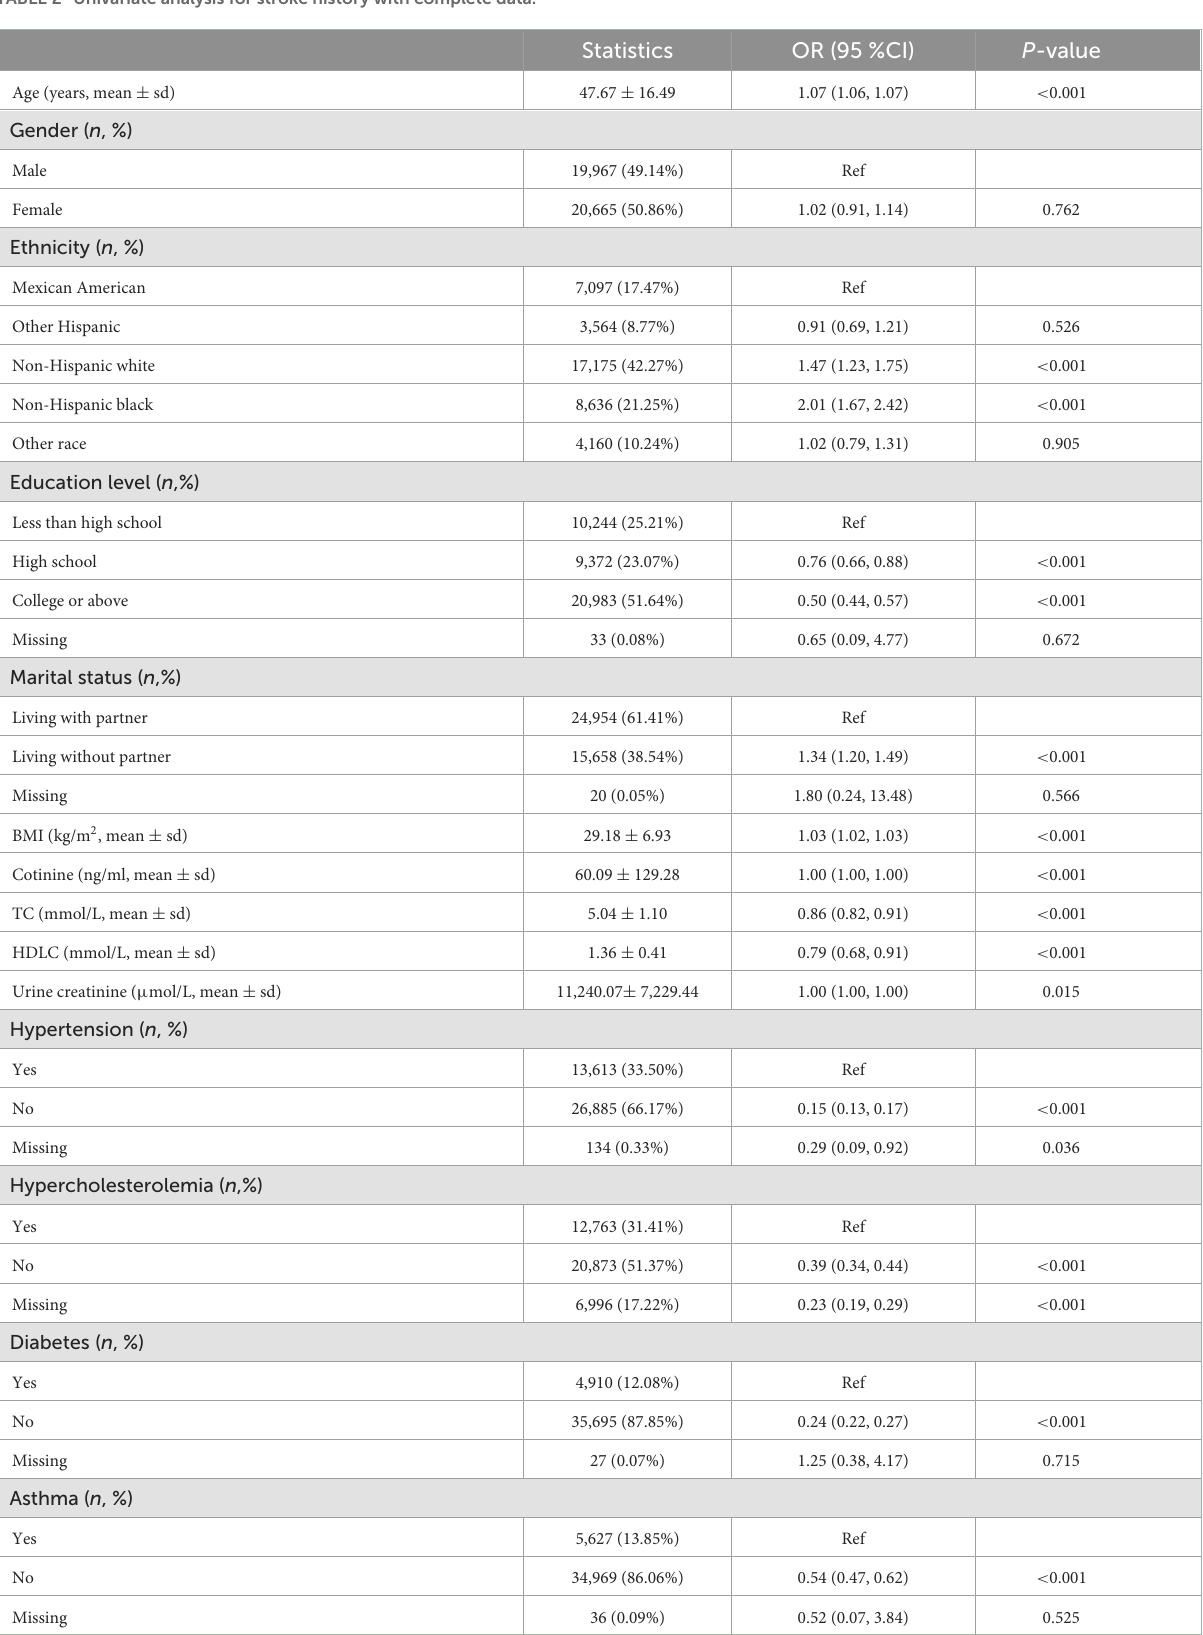
TABLE 2 Univariate analysis for stroke history with complete